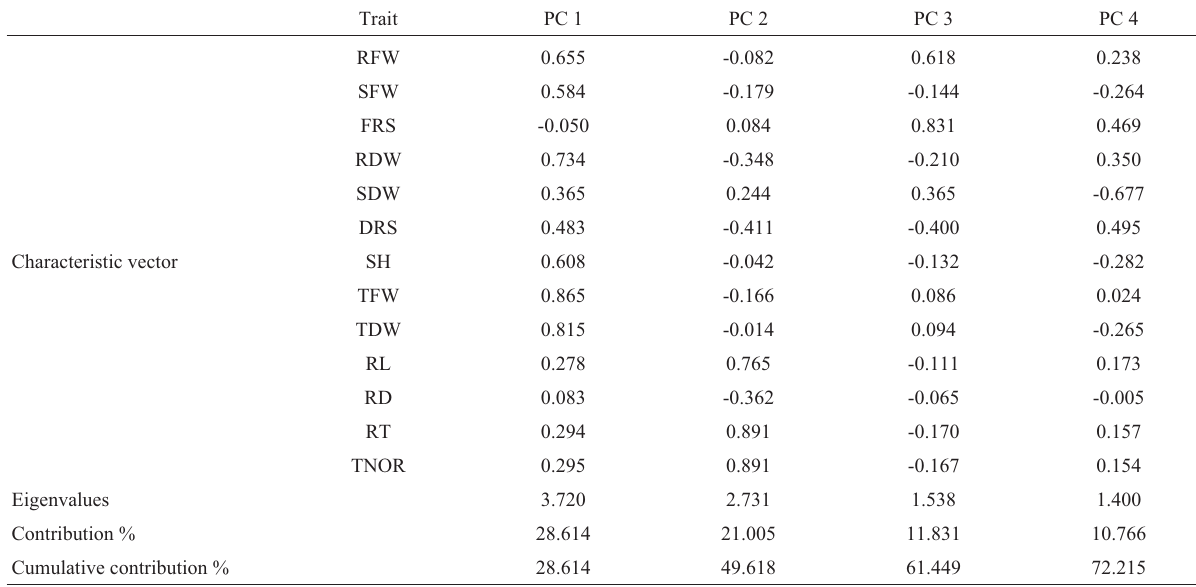
Table 2 - Principal component analysis (PCA). For trait abbreviations see Table 1.